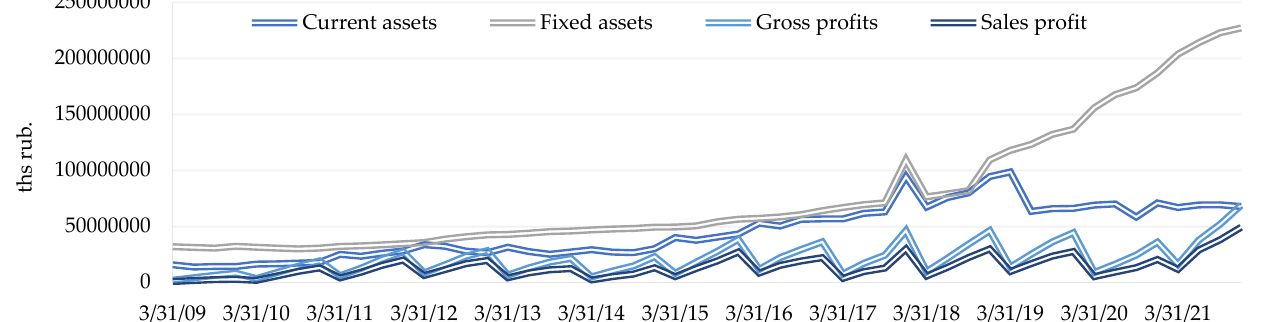
Figure 8. Dynamics of change in input variables over 13 years (quarterly data presented).